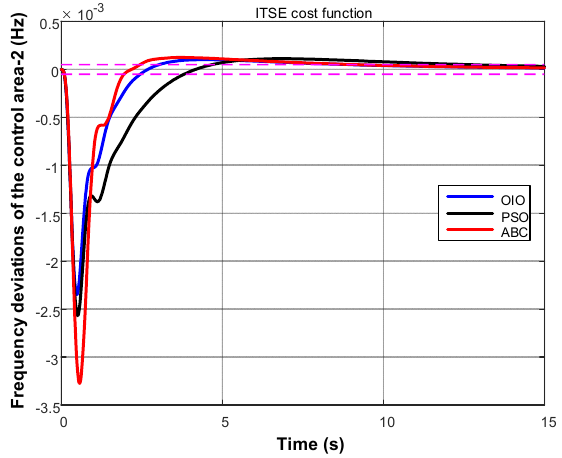
Figure 9. Change in frequency of area ‐ 2 for ISE.